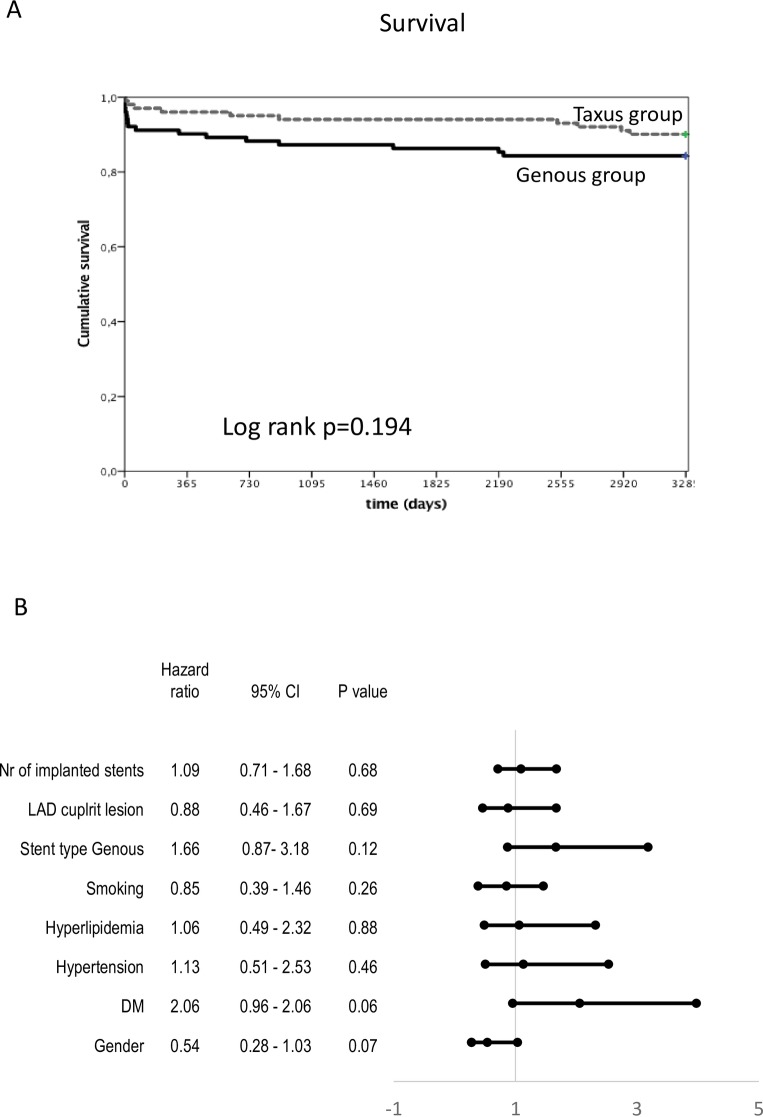
Kaplan-Meier survival analysis in patients with STEMI who received either Genous or TAXUS Liberté stents at the primary percutaneous coronary intervention.(A) Cumulative survival. (B) Forest plot of survival in the indicated subgroups. CI = confidence interval; DM = diabetes mellitus; LAD = left anterior descending coronary artery; Nr = number.